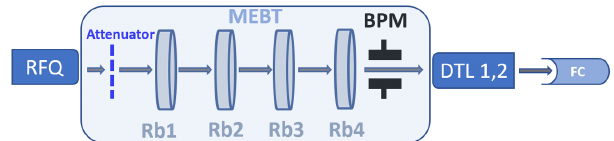
FIG. 1. A schematic layout of the RFQ, MEBT, and DTL 1,2 sections of the SNS linac. Only equipment relevant to the measurements is shown in the picture: a beam current attenuating grid, bunching rf cavities (Rb1, Rb2, Rb3, and Rb4), a beam position and phase monitor (BPM), and a Faraday cup